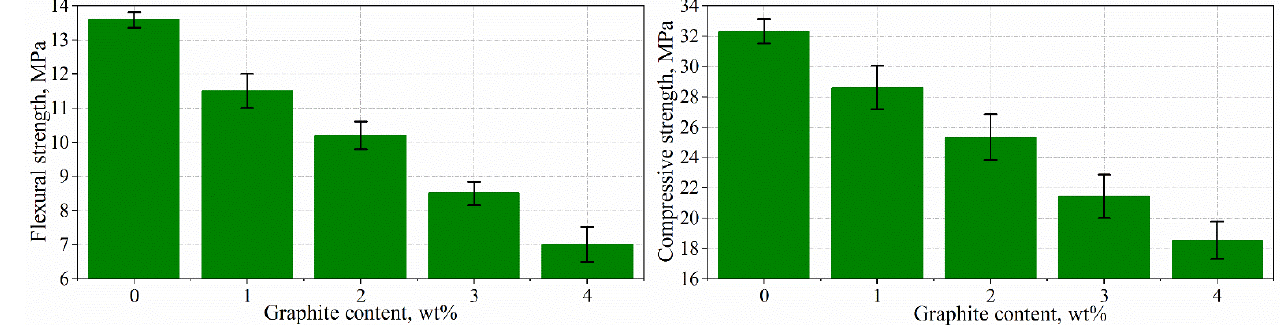
Figure 6. Flexural and compressive strengths of composites with exfoliated graphite.